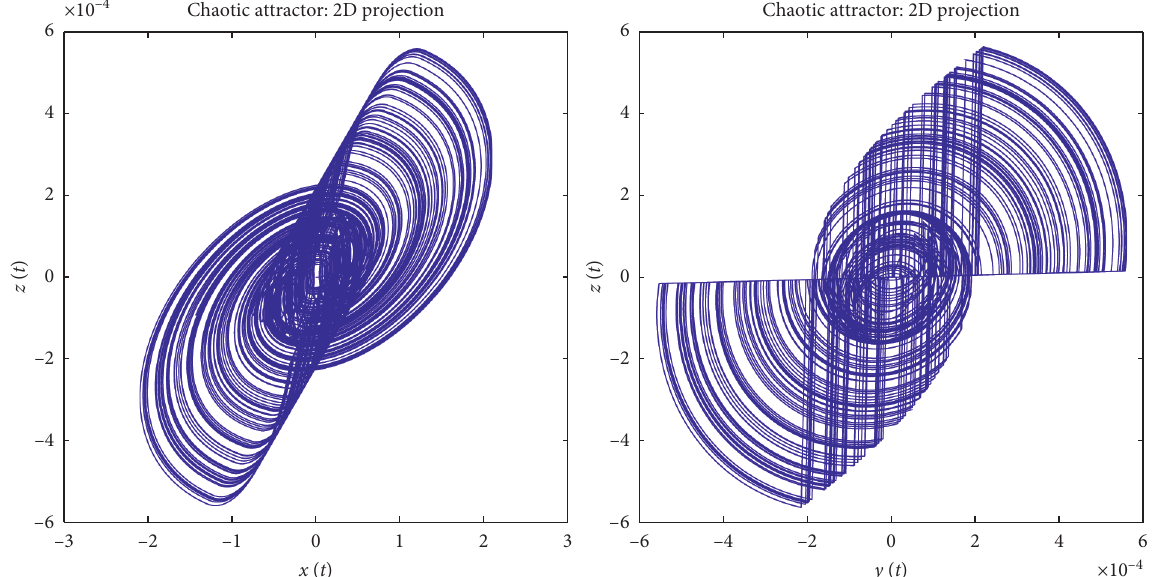
Figure 4: Chaotic attractor in the phase diagram based on the encryption method.